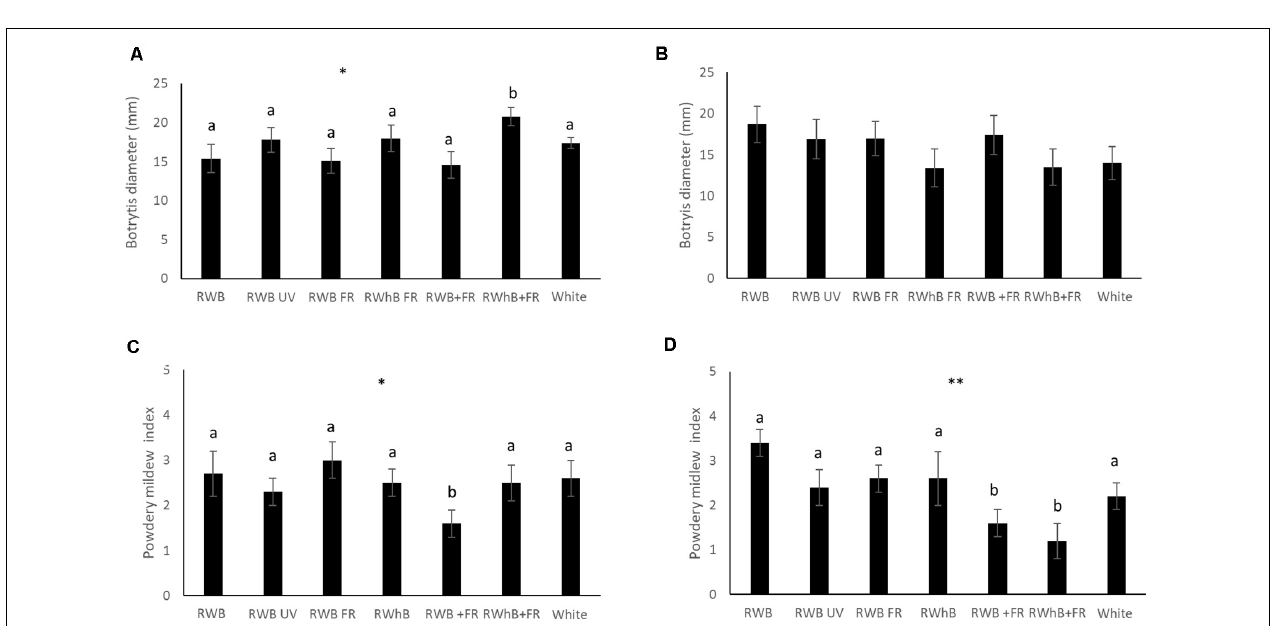
FIGURE 4 | Effect of spectral composition on eggplant host plant resistance (varieties Tracy, Beyoncé, and Lemmy) to B. cinerea in panel (A) the vegetative and (B) the generative phase, and to powdery mildew ( Oidium lycopersicum ) in panel (C) the vegetative and (D) the generative phase. Data represent the mean ( n = 2, 6 plants per treatment per variety) ± standard error of the mean. Data were analyzed with ANOVA for botrytis and with a χ 2 test for powdery mildew. Different letters denote significant differences between treatments at * P ≤ 0.05 and ** P ≤